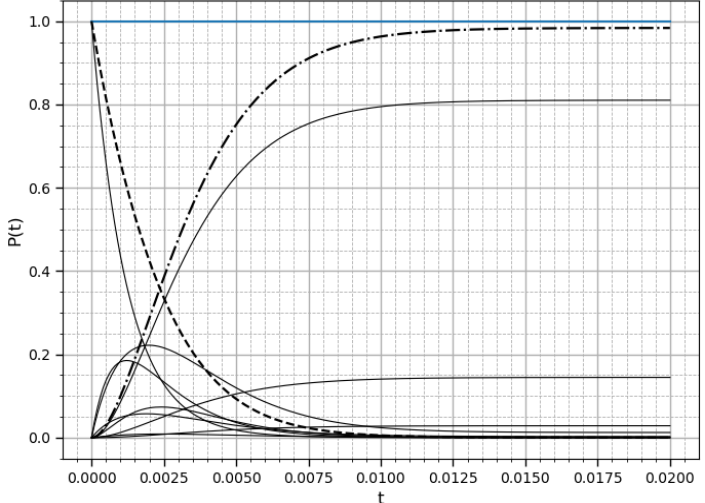
Figure 8. Dependence of the system throughput on time.